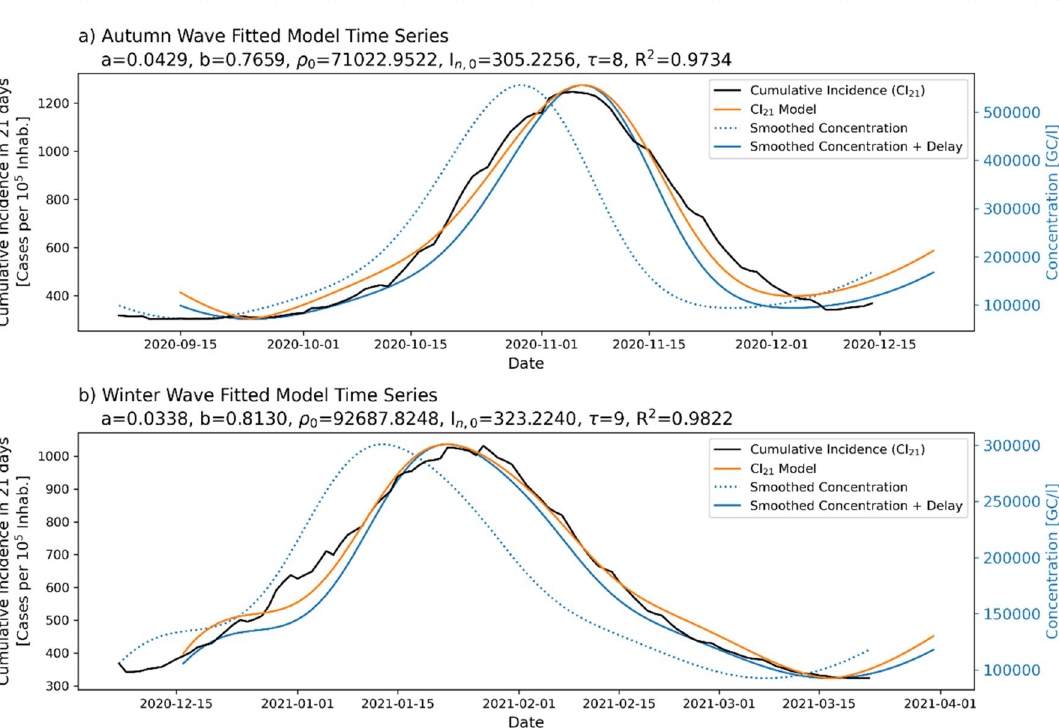
Figure 5. Fitted model for the global population-averaged dataset for the two studied contagion waves. The blue dotted line shows the smoothed concentration, the solid blue line shows the concentration after applying the optimal delay, the black solid line shows the interpolated incidence, and the orange line shows the optimal fitted incidence